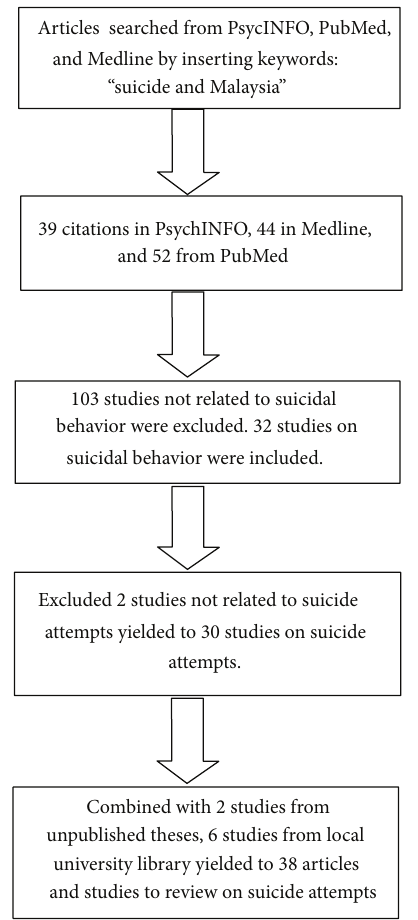
Figure 1: Flow chart of the reviewing